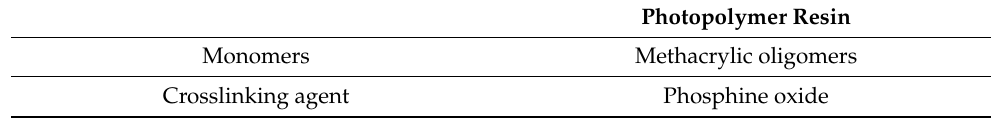
Table 1. The component of photopolymer resin (MAZIC D TEMP).